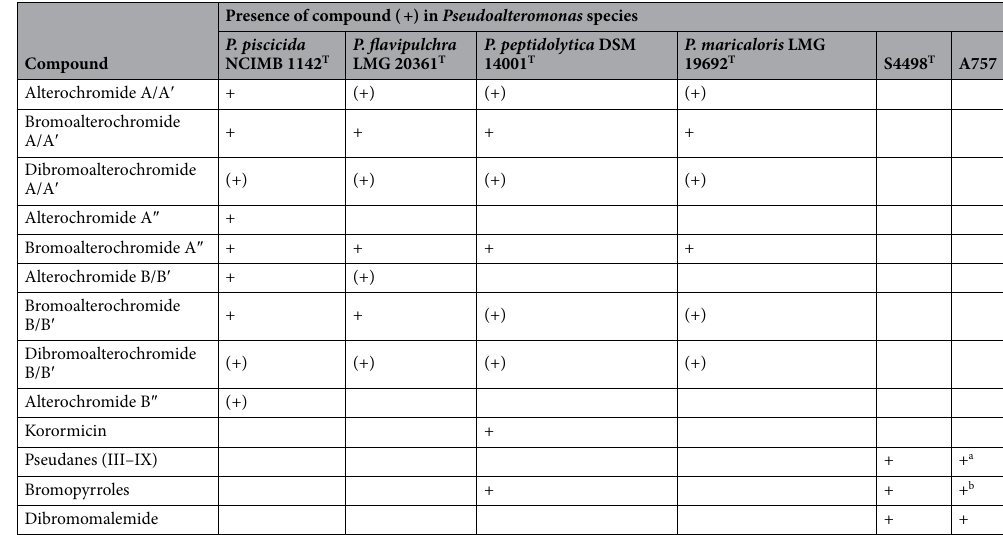
Table 4. Known secondary metabolites detected in P. galatheae S4498 T and four Pseudoalteromonas type strains based on UHPLC-DAD-HRMS/MS analysis, as well as reported metabolites from strain A757. + = detected; (+) = detected in trace amounts. a Only pseudane VII has been reported 21 . b Only tetrabromopyrrole (TBP) has been reported 20